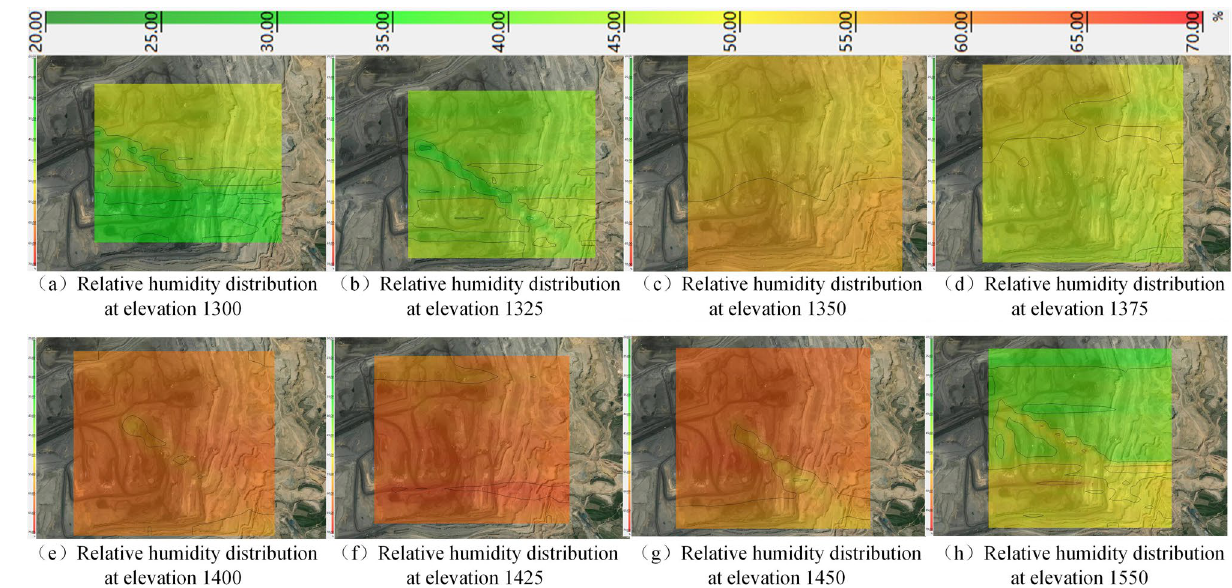
Figure 9. Relative humidity distribution from 1300 to 1550 elevation in winter.